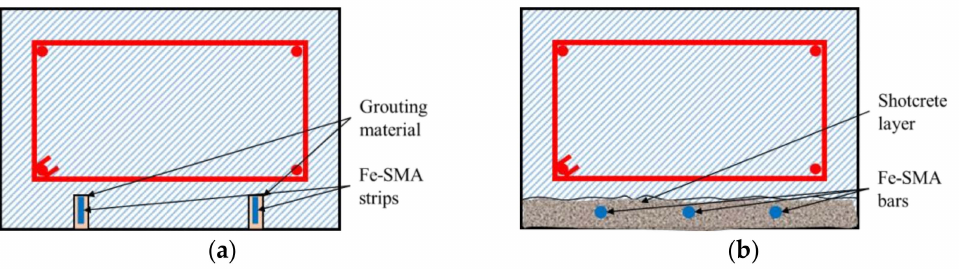
Figure 11. Cross-section of reinforced beams with different methods (adapted from [102]): ( a ) NSM; ( b )